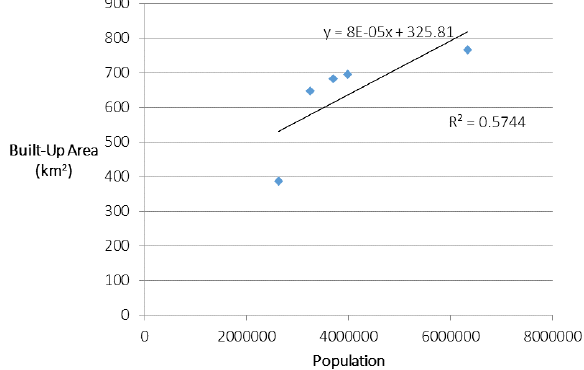
Fig. 8. Relationship between population and built-up